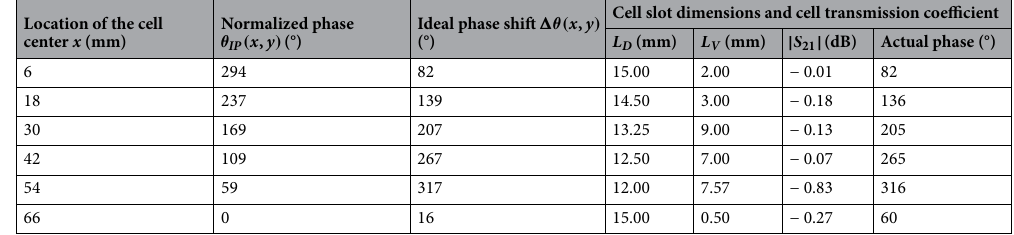
Table 1. Center position, dimensions and transmission coefficient of each